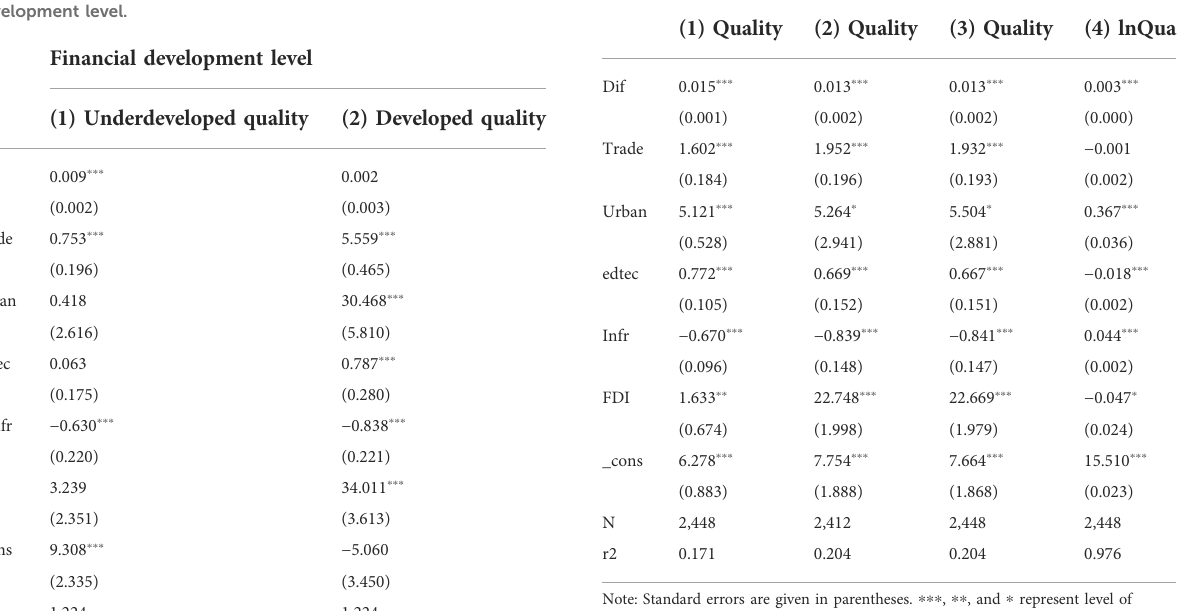
TABLE 7 Results of robustness